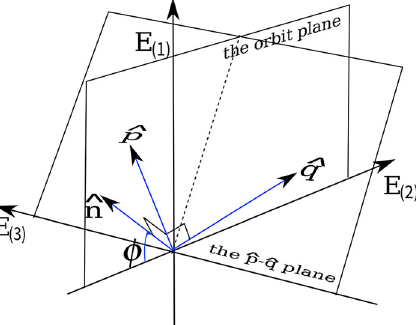
Fig. 1 The axes of the gradiometer are oriented as follows, ˆ p and ˆ q are symmetric with respect to the E to the ˆ p − ˆ q plane. The angle between ˆ n and − E